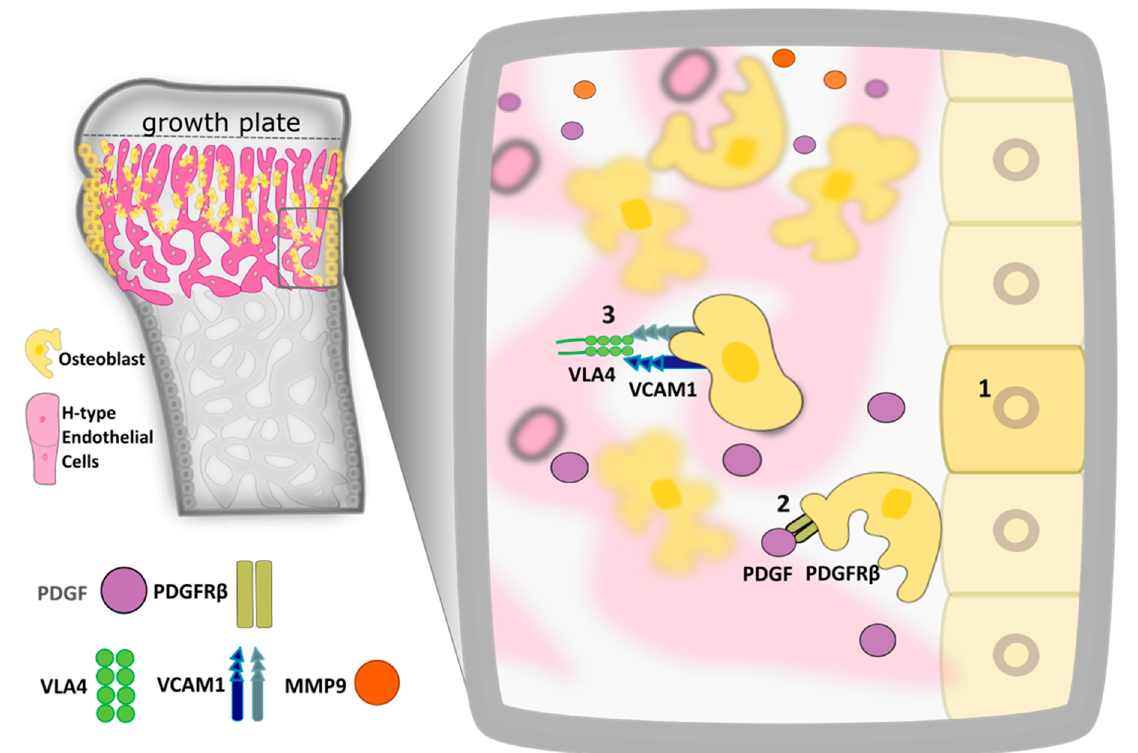
Figure 2. Cellular and molecular factors regulating osteoblast-EC angiotropism during bone growth and repair. Diagram illustrates the three main stages of osteoblast angiotropism. (1) MSC to osteoprogenitor differentiation occurs in response to local cues from the bone niche. Factors include oxygen and nutrient availability as well as HIF-1 α and WNT/ β Catenin signaling. Note the different morphology of osteoprogenitors not associated to vessels and their localization in the endosteum and periosteum. (2) Expansion of the Osx+ osteoprogenitor pool via proliferation under the influence of PDGF-PDGFR β signaling, which favors maintenance of a pro-migratory immature osteoblast phenotype. (3) Osteoblast migration to sites of bone formation and repair alongside expanding H-type capillaries. PDGF acts as a chemoattractant to PDGFR β + osteoprogenitors in the near vicinity. Subsequent to PDGF-PDGFR β signaling, MMP-9 is also secreted by osteoblasts to aid in degradation of the surrounding matrix. MMP-9 expression is particularly increased at the vascular front during active angiogenesis. Cell-to-cell contact is required to facilitate osteoblast adhesion to EC. For example, VLA4-VCAM-1 interaction facilitates osteoblast angiotropism by enabling anchorage of the osteoblast cell membrane to H-type